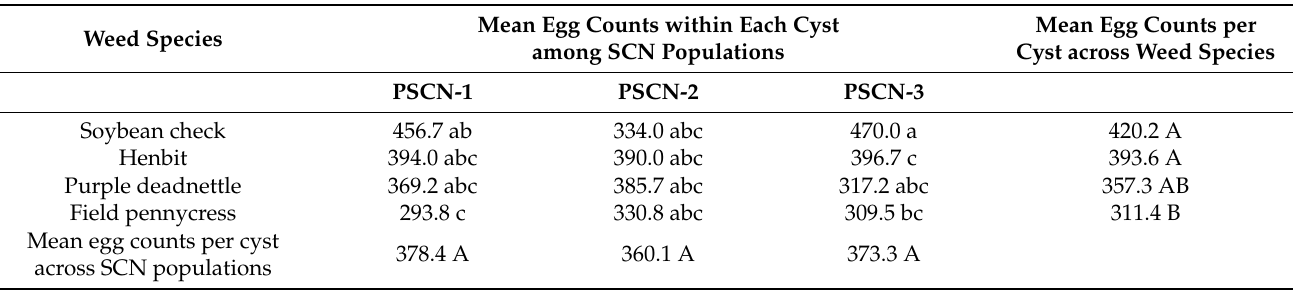
Table 5. Number of soybean cyst nematode (SCN) eggs per cyst collected from field pennycress, henbit, purple deadnettle, and susceptible check soybean